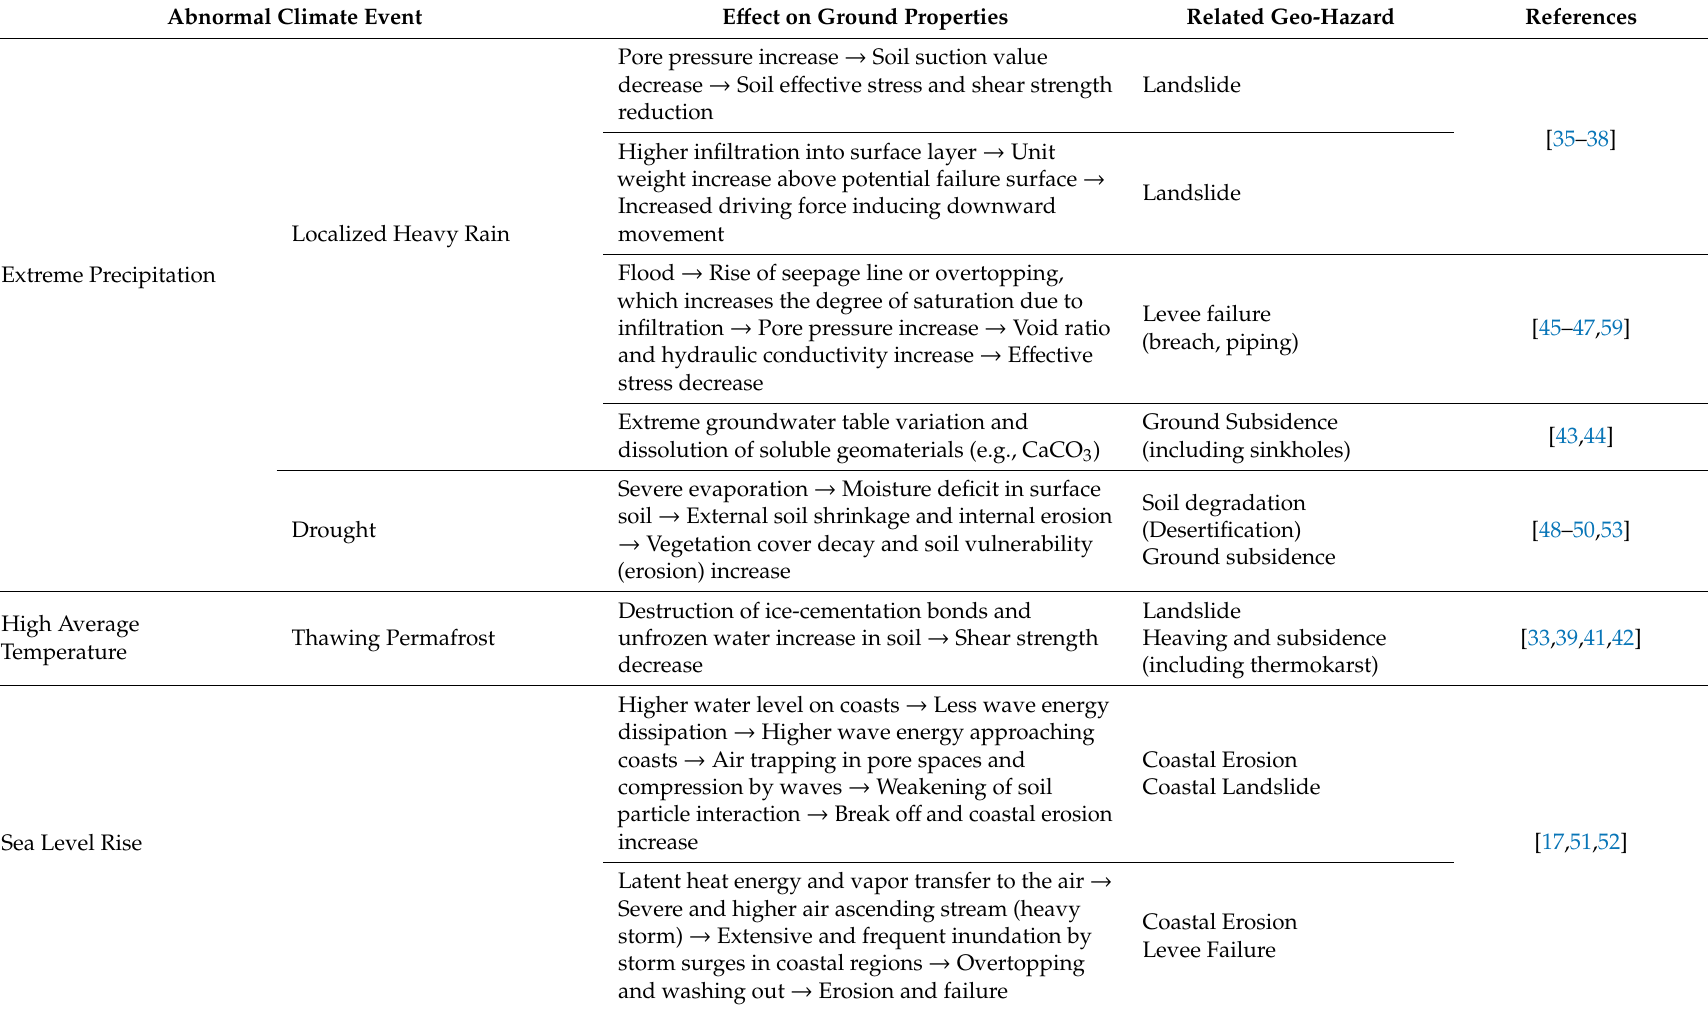
Table 1. Overview of abnormal climate events and their e ff ect on ground